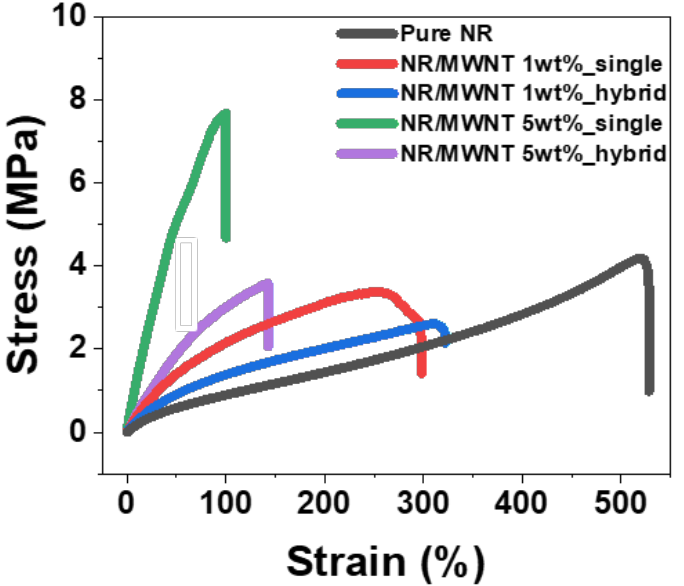
Table 1. Mechanical properties of pure NR and MWNT/NR composite.